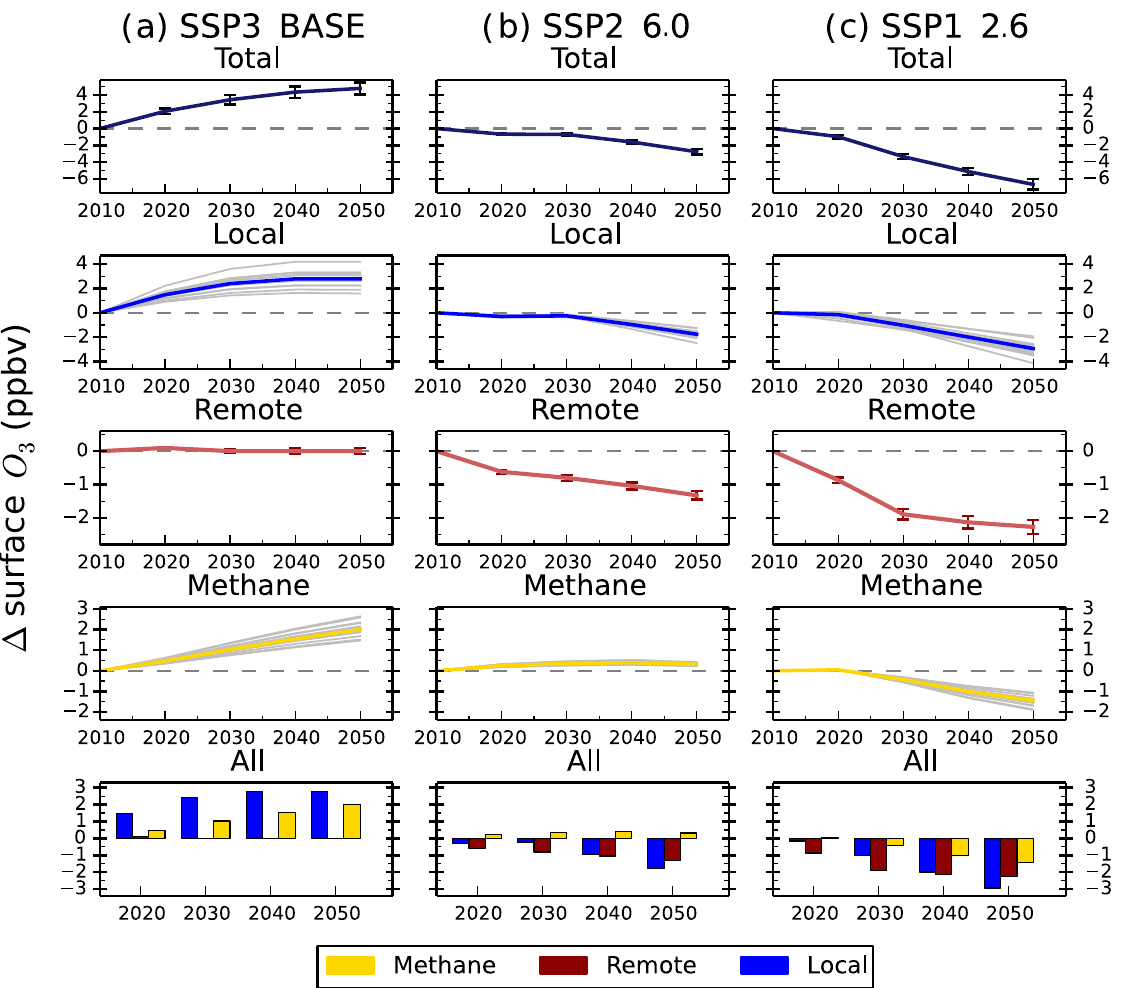
Figure 11. Same as Fig. 10 but for the south Asia